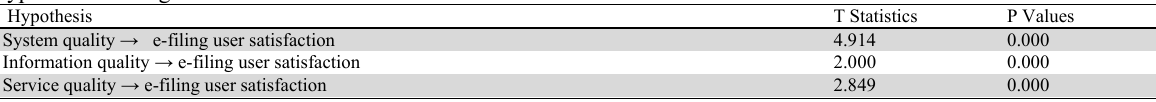
Hypothesis testing